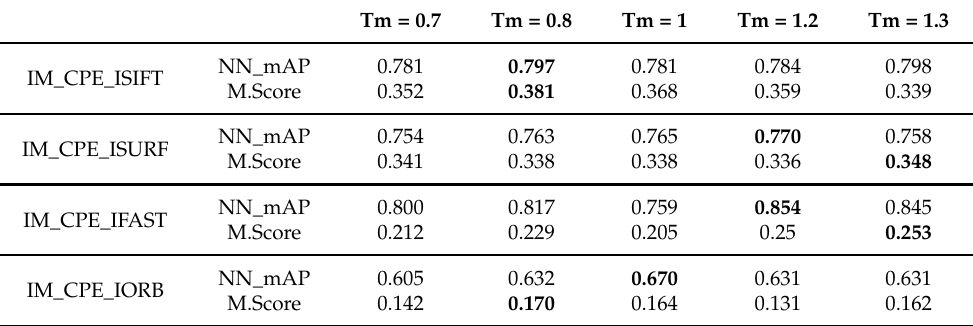
Table 3. Comparison of results of IM_CPE using four kinds of key points with various T M s in terms of NN_mAP and M.Score in ‘sitting rpy’ sequence.